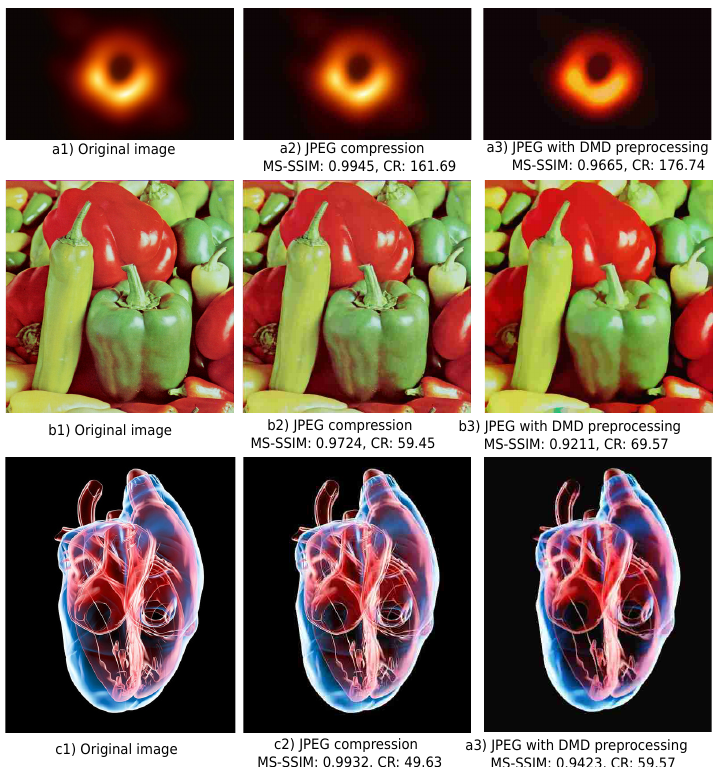
Figure 13. Comparison of plain JPEG ( a2 – c2 ) with CDMD applied as preprocessor to JPEG ( a3 – c3 ) for three